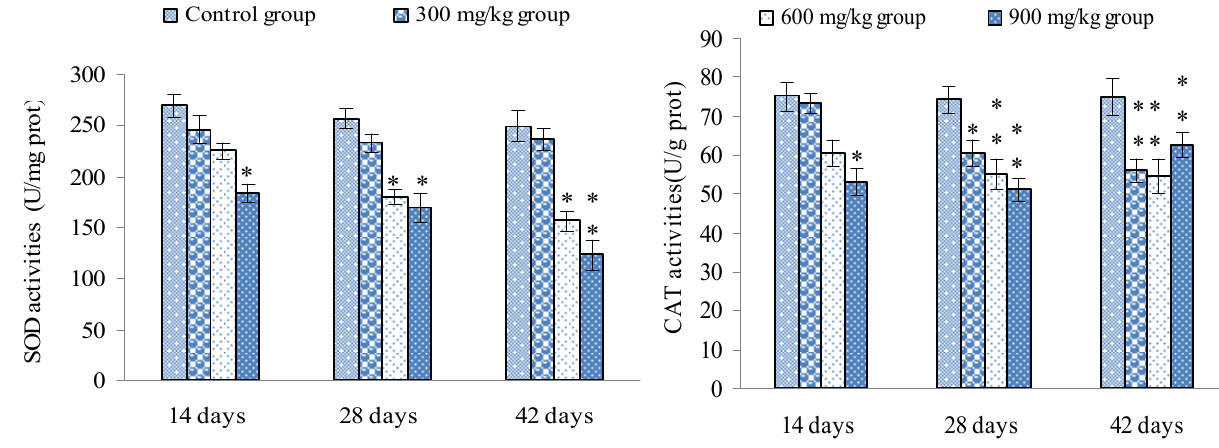
Figure 8. Changes of the oxidative stress parameters in the